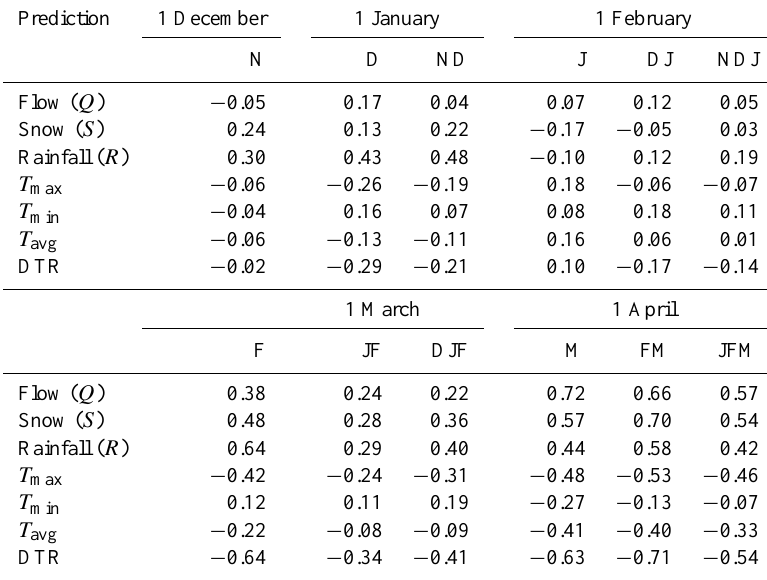
Table 3. Pearson’s correlation coefficients between average MAMJ inflow into Bhakra and spatially averaged Satluj River basin climatology (showing setting 1 datasets) and inflow for